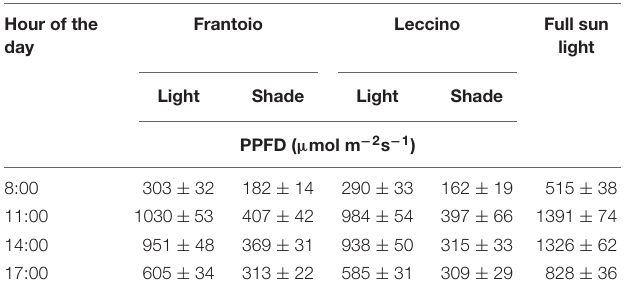
The light availability at the full sun near the considered trees is also